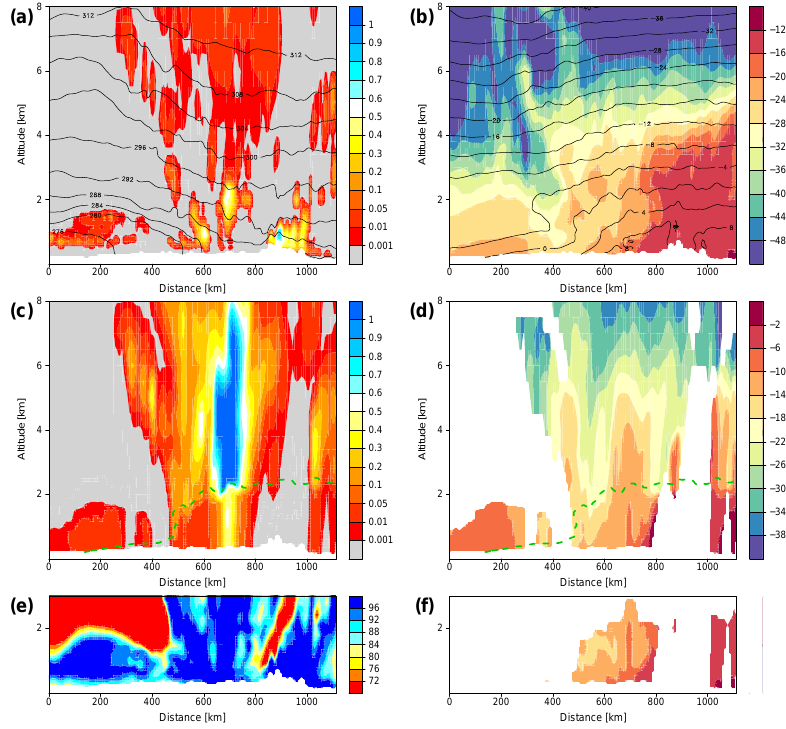
Fig. 10. Vertical cross sections from the COSMO iso reference simulation at 12:00UTC 19 January of (a) the sum of cloud water and ice content (in gkg − 1 ), (b) δ 18 O of water vapour (in ‰), (c) the sum of rain and snow water content (in gkg − 1 ), (d) δ 18 O of rain and snow (in ‰), (e) relative humidity and (f) δ 18 O of rain in isotopic equilibrium with water vapour along the green dashed line shown in Fig. 3d. The horizontal axis gives the distance in km to the westernmost point of the cross section. The contours in (a) and (b) show potential temperature (in K) and temperature (in ◦ C), respectively. The green dashed lines in (c) and (d) indicate the 0 ◦ C isoline. In (e) and (f) , only the lowest part of the section is shown. The colour scale of panel (d) is also valid for (f)